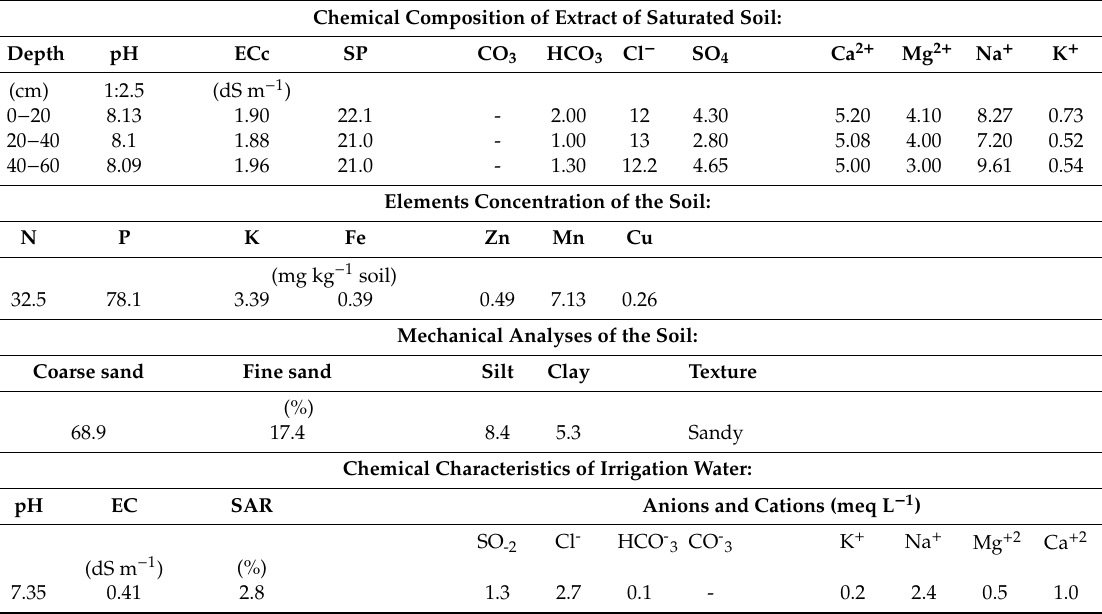
Table 9. Chemical and mechanical composition of extract of saturated soil of the experimental site and chemical characteristics of irrigation water